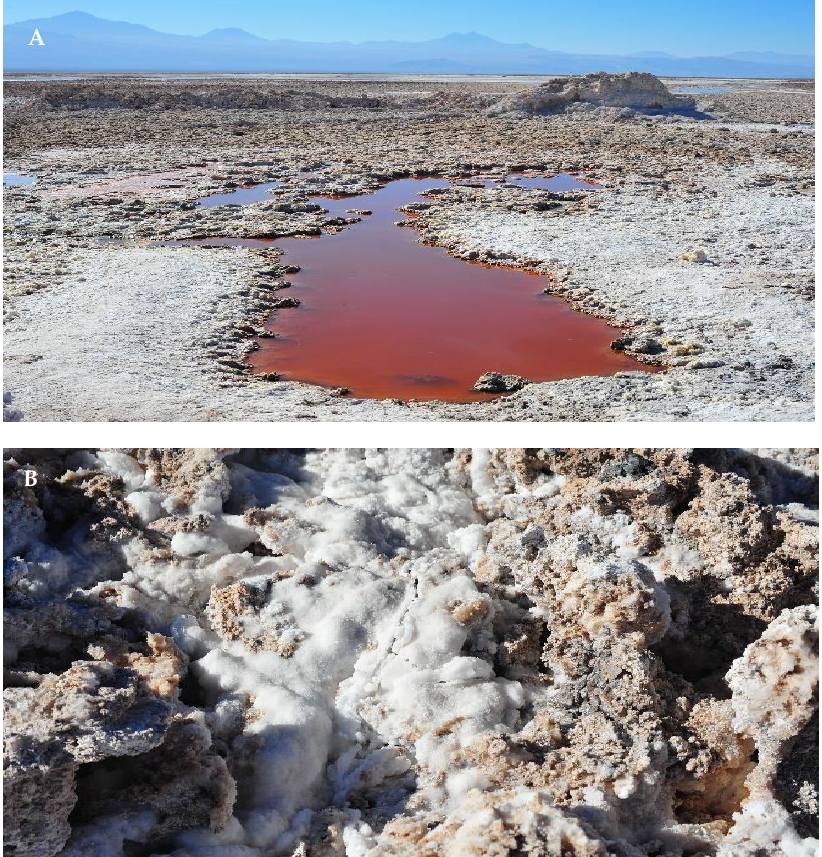
Figure 4. Images of Lake Chaxa: ( A ) a salt-flat lake in Chile wherein red algae impart a reddish hue to the lake, ( B ) higher salt contents and salt crusts that can easily be seen as large white deposits. This lake is the habitat of halophilic organisms including the red algae Dunaliella . These species thrive in high salt conditions, and the briny lake is an ideal habitat for these halophiles. Photo credit to